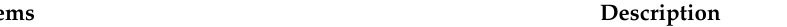
Table 2. Schematic description of macrophage contribution in oxidative stress, inflammation, and fi- brosis. Abbreviations: ROS (reactive oxygen species); RNS (reactive nitrogen species); NADPH (nicoti- namide adenine dinucleotide phosphate); TNF- α (tumor necrosis factor-alpha); IL-1 β (interleukin- 1beta); IL-12 (interleukin-12); IL-6 (interleukin-6); CCL-2 (chemokine C-C motif ligand-2); TGF- β (tumor growth factor-beta); EMT (epithelial mesenchymal transition); ECM (extracellular